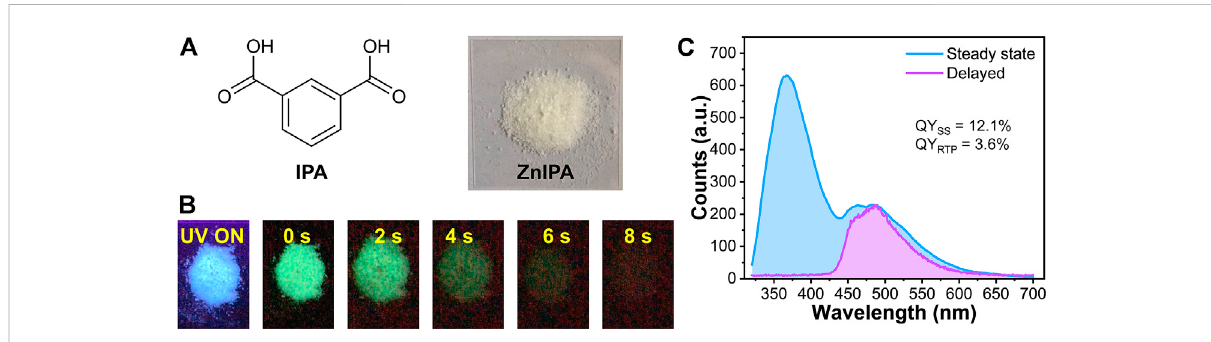
FIGURE 2 (A) Chemical structure of isophthalic acid (IPA) and photograph of ZnIPA MOF (B) Photographs of ZnIPA under and after excitation of UV (365 nm) light (C) Steady-state photoluminescence (PL) and delayed RTP spectra of ZnIPA. The blue- and purple-colored fi llings represent the integrating areas of steady-state PL and delayed RTP, respectively. λ ex = 300 nm. For steady-state PL and QY SS , the excitation power is 52.6 mW cm − 2